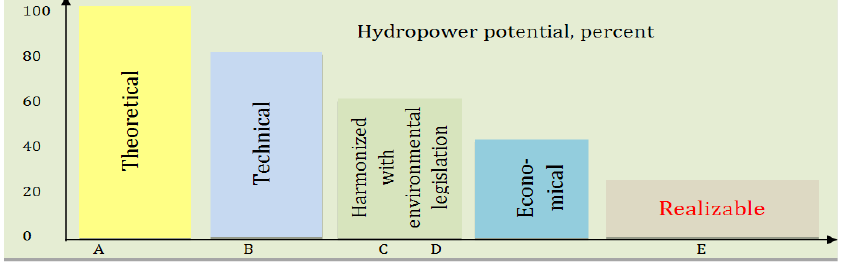
Fig. 1. Decrease of hydropower resources due to various restrictions (Punys et al.,